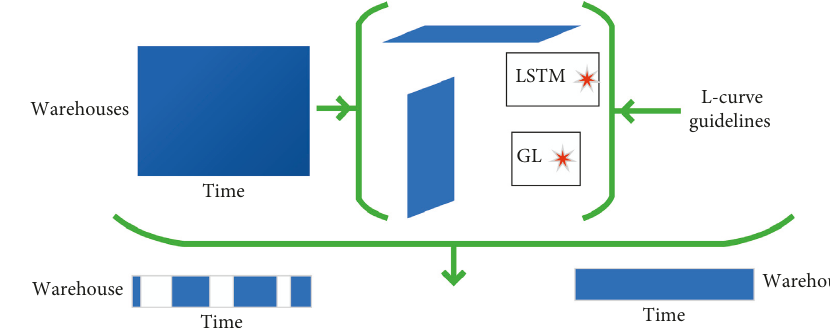
Figure 1: Illustration of improved LSTM-GL-ReMF.